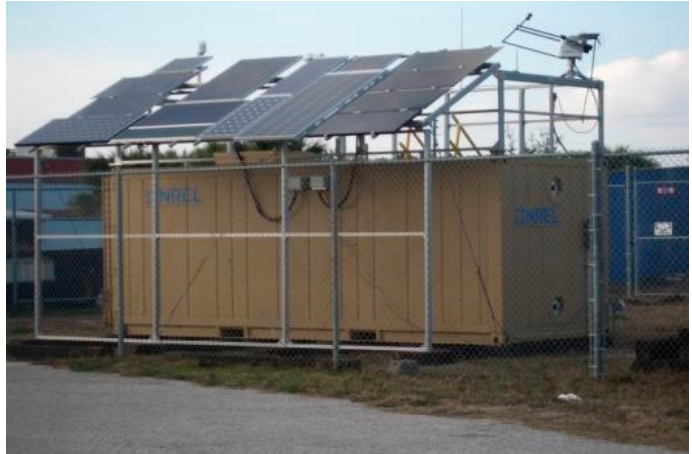
Figure 1. Deployment of PV modules and equipment in Cocoa, Florida.